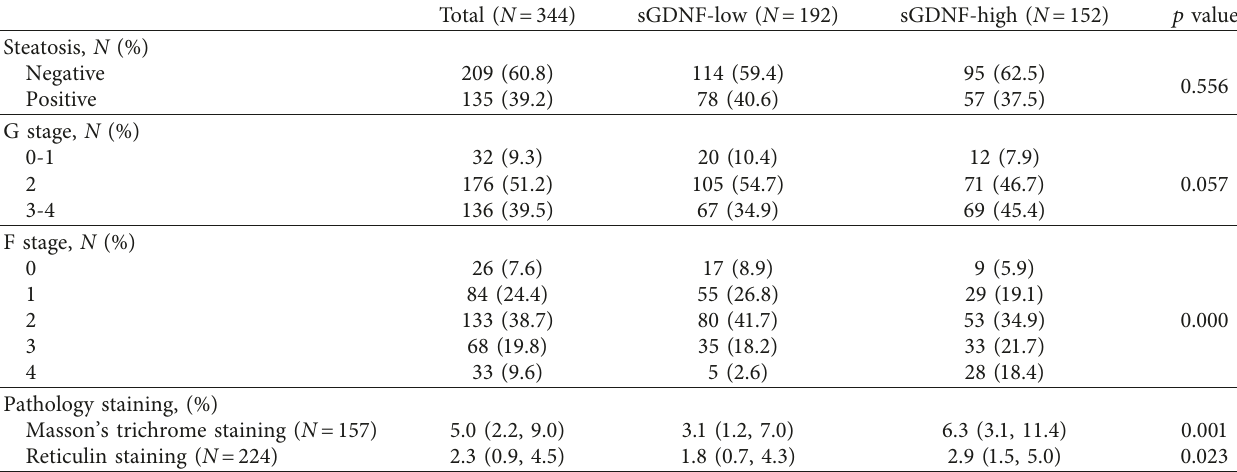
Table 3: Characteristics of study participants relative to their sGDNF levels.